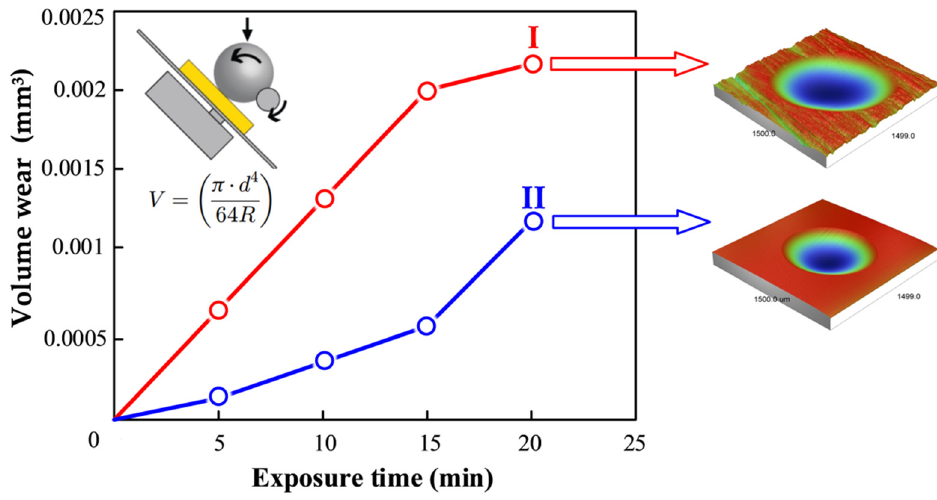
Figure 5. Dependences of the volume wear of Al 2 O 3 +TiC ceramic inserts with the different conditions of the surface layer (I—diamond grinding; II—diamond grinding, lapping and polishing) on the time of abrasive exposure.